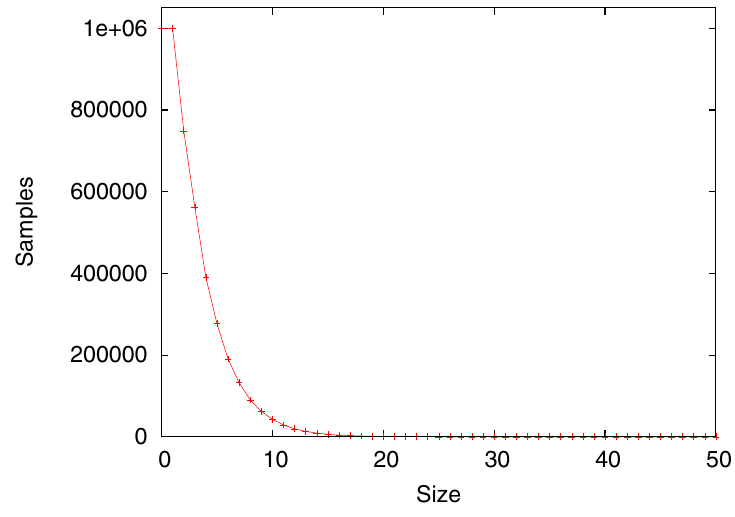
Fig. 2. Attrition of started walks generated with Simple Sampling. From 10 6 started walks none grew more than 35